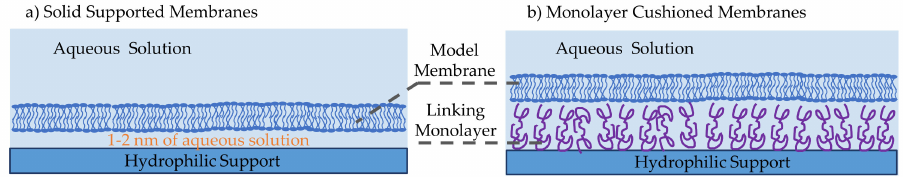
Figure 4. Model membranes are formed on a solid substrate in two configurations. ( a ) Solid supported membranes are formed at the planar surface of a hydrophilic solid support. The bilayer is formed through LB/LS method or vesicle fusion method or a combination of both. The resulting membrane is stable, mechanically robust and long-lasting as a result of localized tight lipids packing and the presence of the underneath solid support. ( b ) The introduction of a linking interstitial region between the solid support and the membrane leads to a larger aqueous environment beneath the membrane. This facilitates the introduction of proteins and larger biomolecules in a safe and unconstrained setting. The joining monolayer can be formed through a polymer, a protein, thiolipids or other amphiphilic